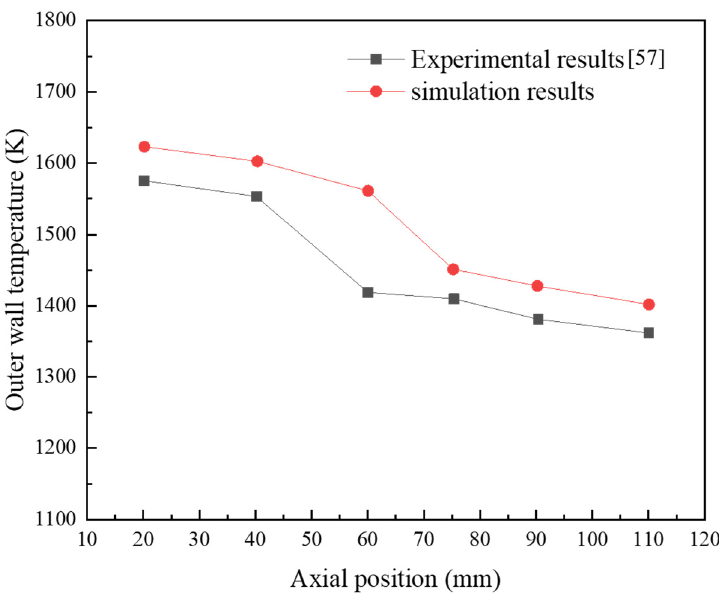
Figure 4. Numerical and experimental